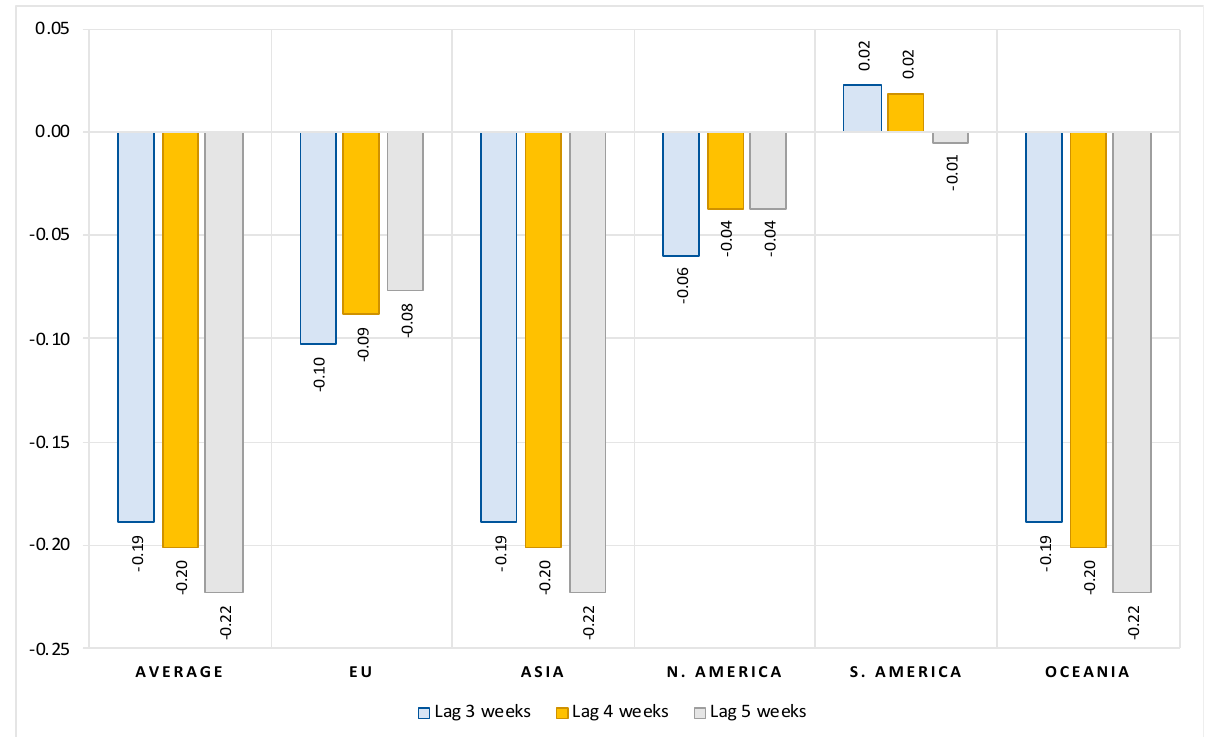
Figure 5. Impact of vaccination rate on number of new ICU patients, limited data sample *. Notes: Figure contains the estimated elasticities of the per-million number of new ICU patients to vaccination rate obtained by estimating the model (2). (*) Data available only for most European countries, United States, Canada and Israel. See Table A5 in the Appendix A for the full results.